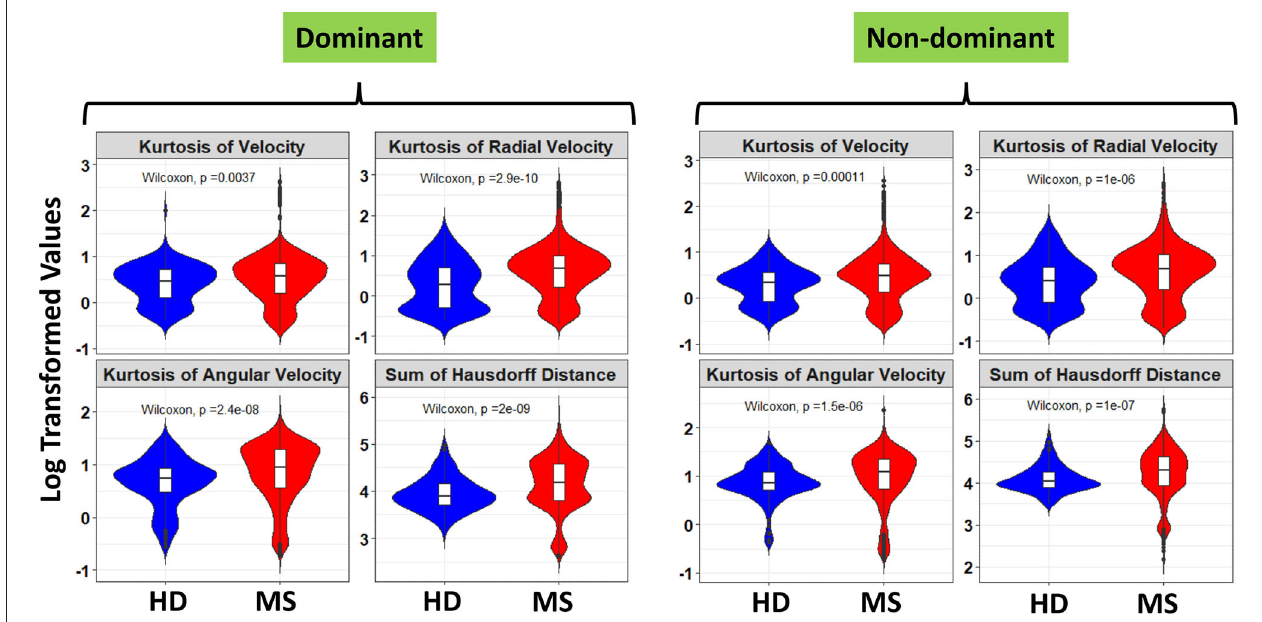
FIGURE 7 | Violin and boxplot of the selected spiral-derived features with FC > 2 and ICC > 0.5 with respect to healthy donors and patients with MS at the difficulty level 3. The blue color indicates the healthy donors while red shows the patients with MS. There were multiple tests per subject in the HD and MS group. Values are shown using a bi-symmetric log transformation for both the dominant and non-dominant hand (The p indicates the p -value of the unpaired Two-Samples Wilcoxon test for the mean comparison of HD and MS groups).